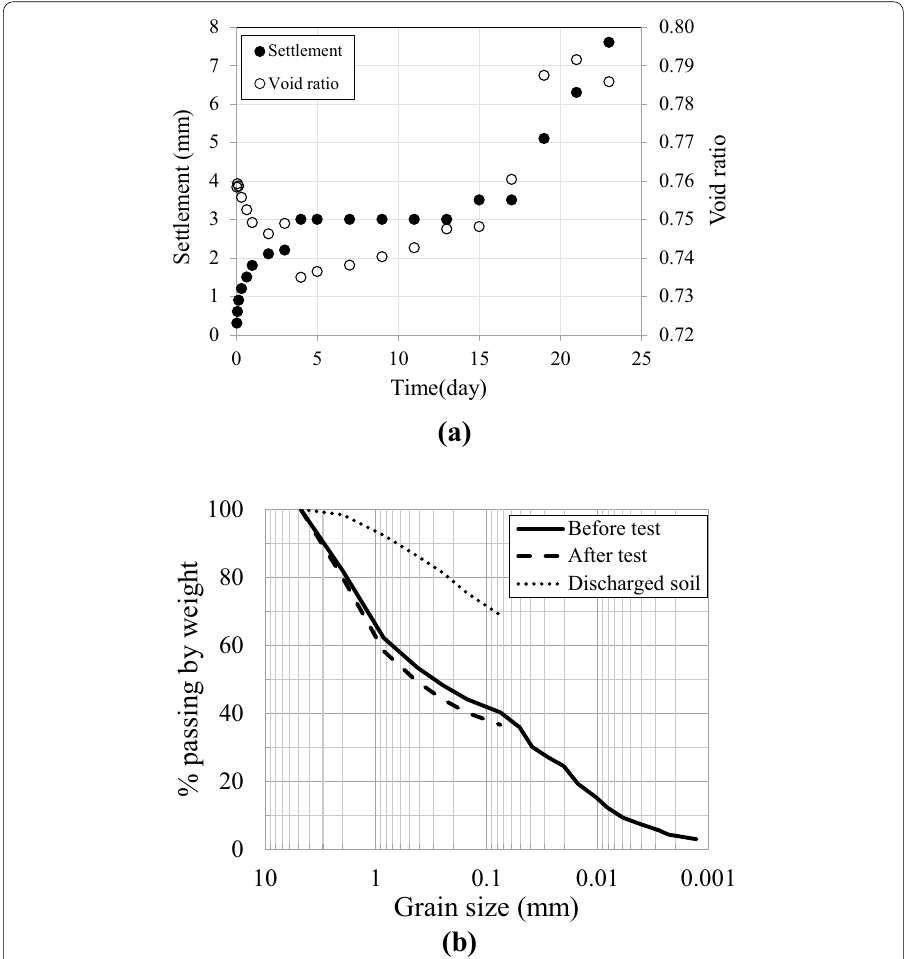
Fig. 7 Long‑term test results of Gwanak soil: a settlement and e ; and b grain size distribution after the